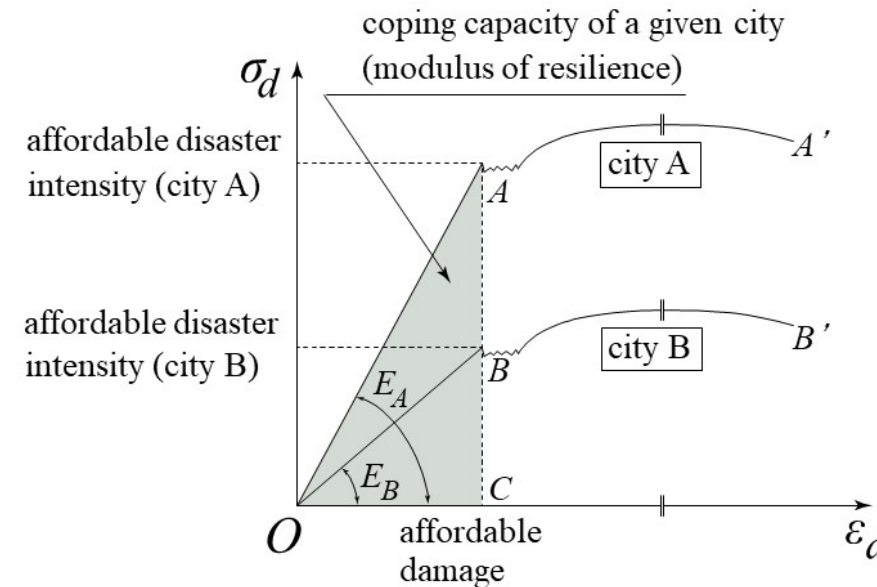
Figure 2. An illustration showing how city A and B respond differently on intensity of a given disaster.